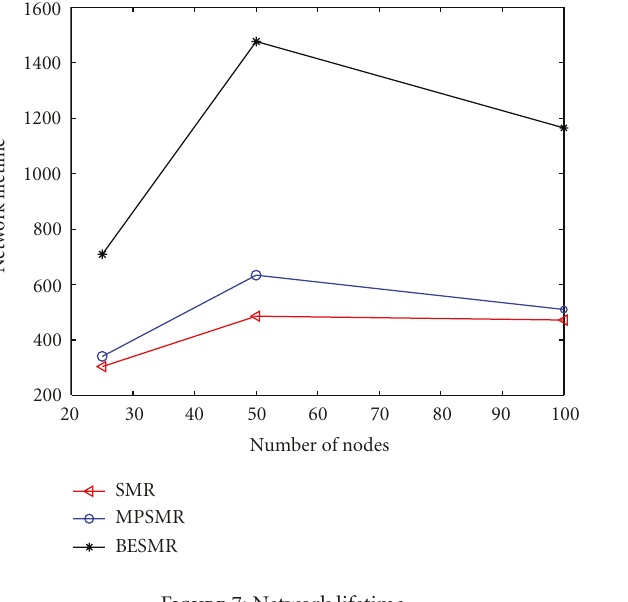
Figure 7: Network lifetime.